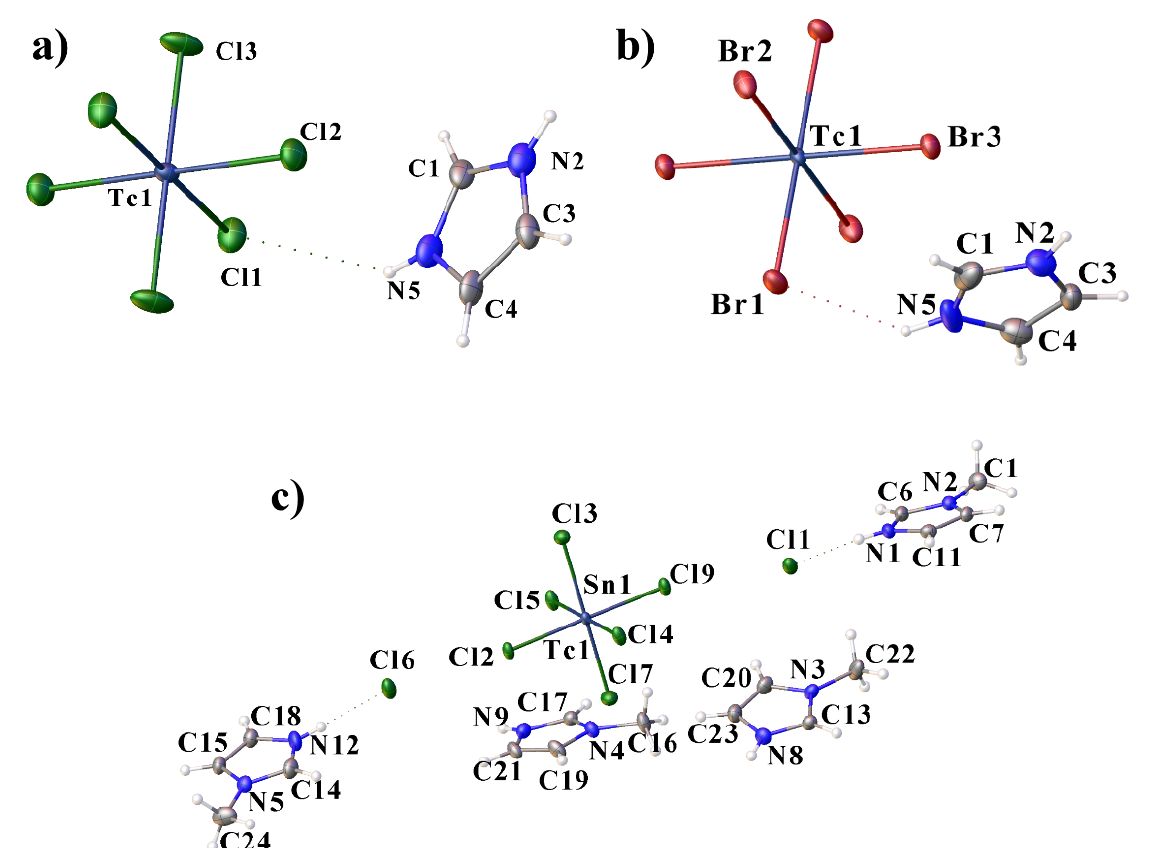
Figure 5. Molecular structure of VI (a), VII (b) and VIII (c) .